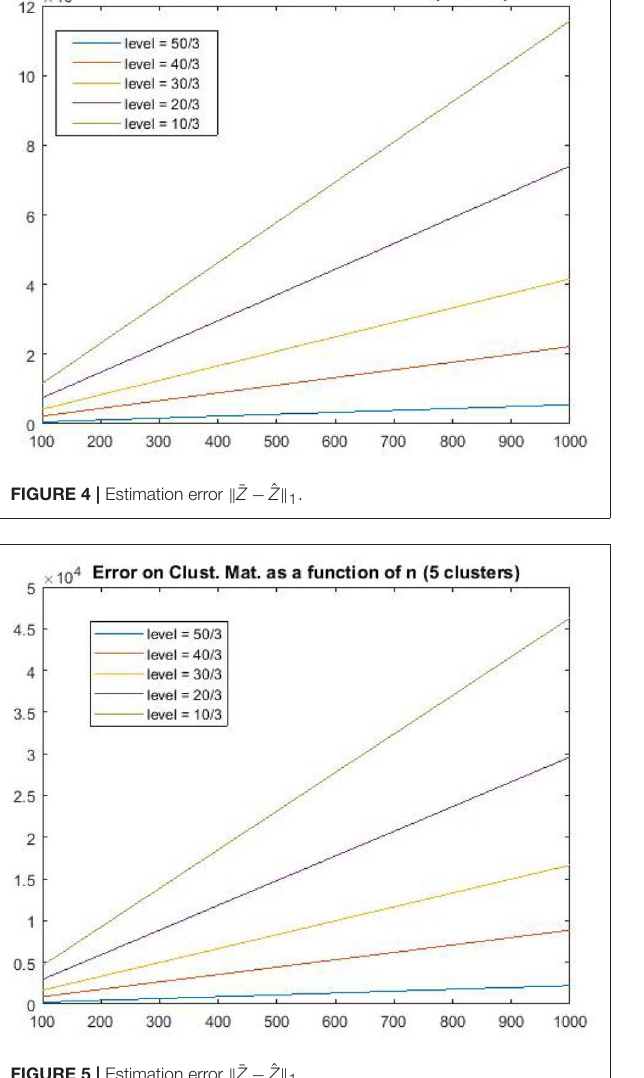
FIGURE 5 | Estimation error k¯ Z